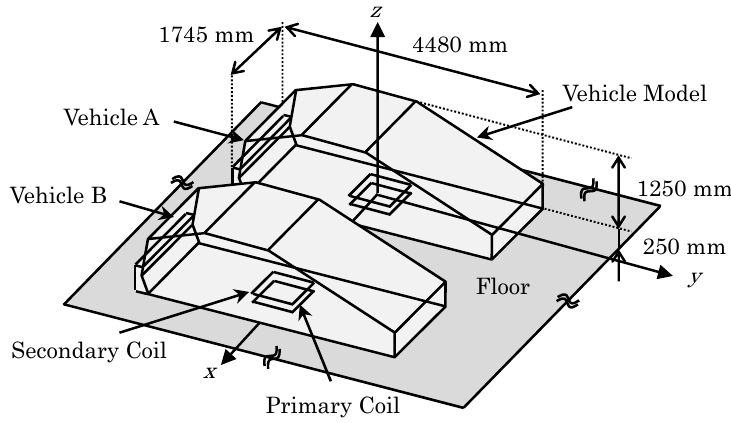
Figure 1. Analysis model of vehicles A and B.